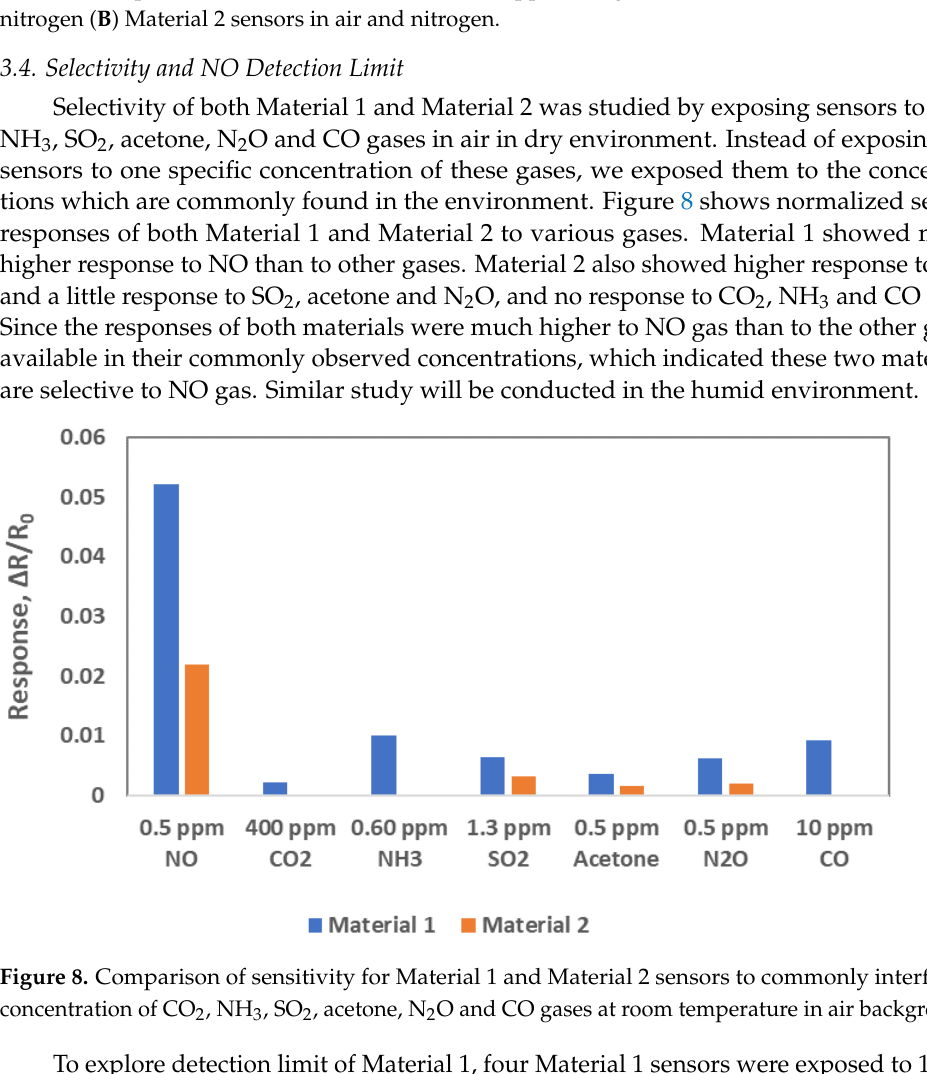
Figure 7. Responses (ΔR/R 0 ) to 0.02, 0.04, 0.12, 0.5ppm NO gas ( A ) Material 1 sensors in air and nitrogen ( B ) Material 2 sensors in air and nitrogen.